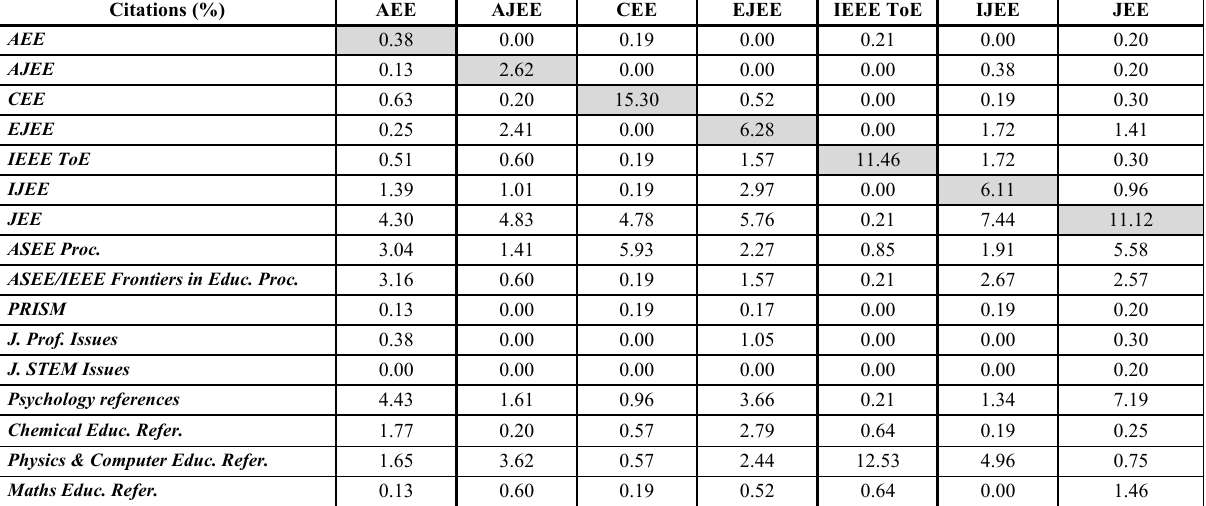
TABLE VII. S OURCES CITED IN THE JOURNALS IN